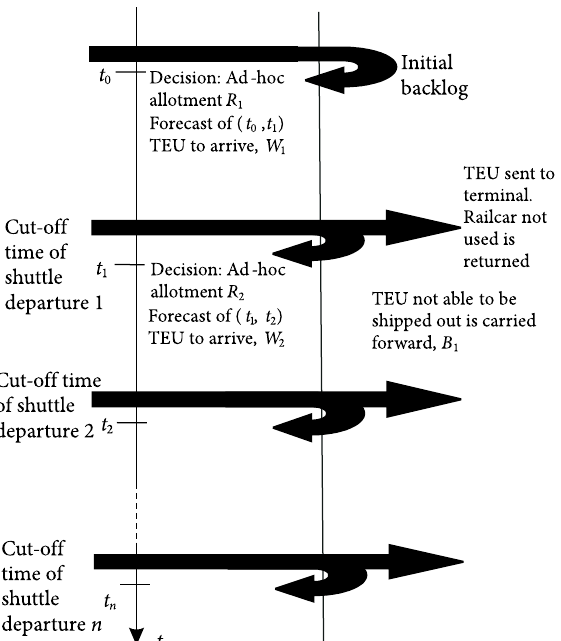
Fig. 1. Short term capacity planning problem of intermodal shuttle operator